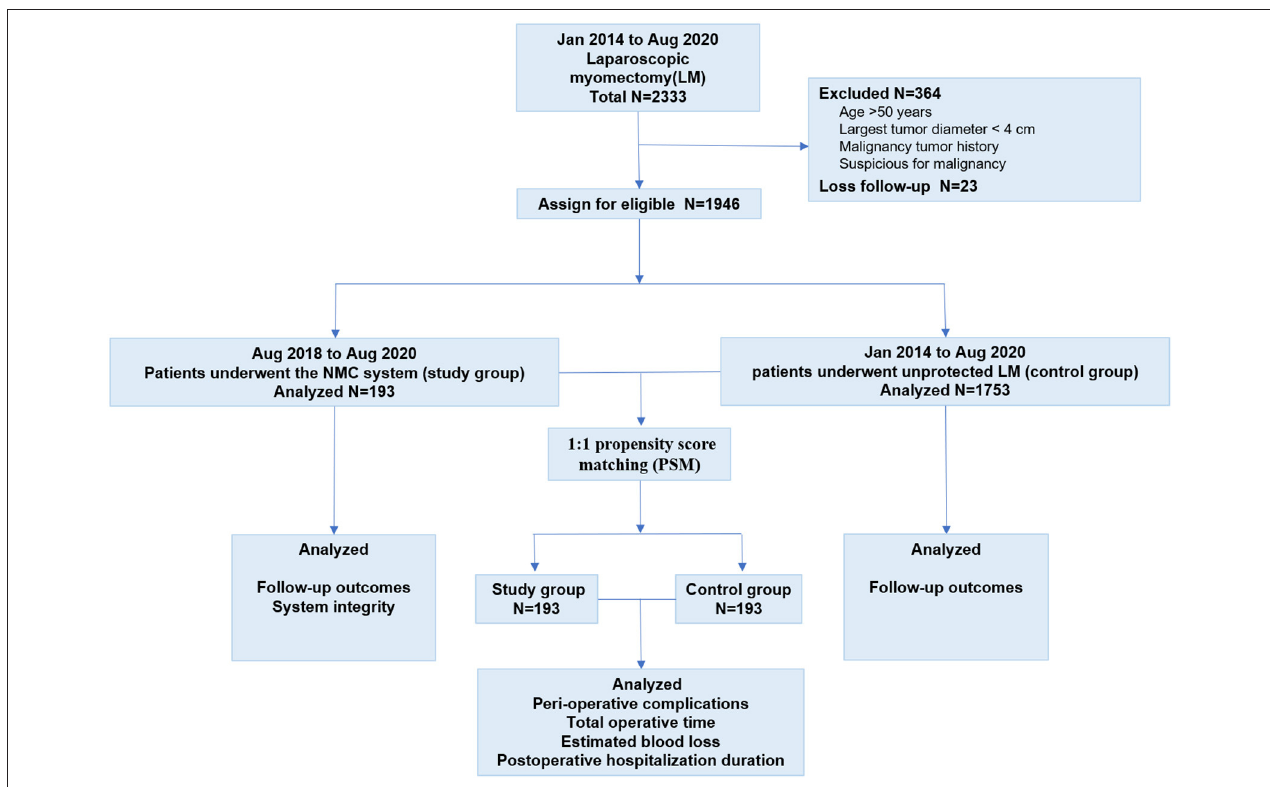
FIGURE 1 | Study design.